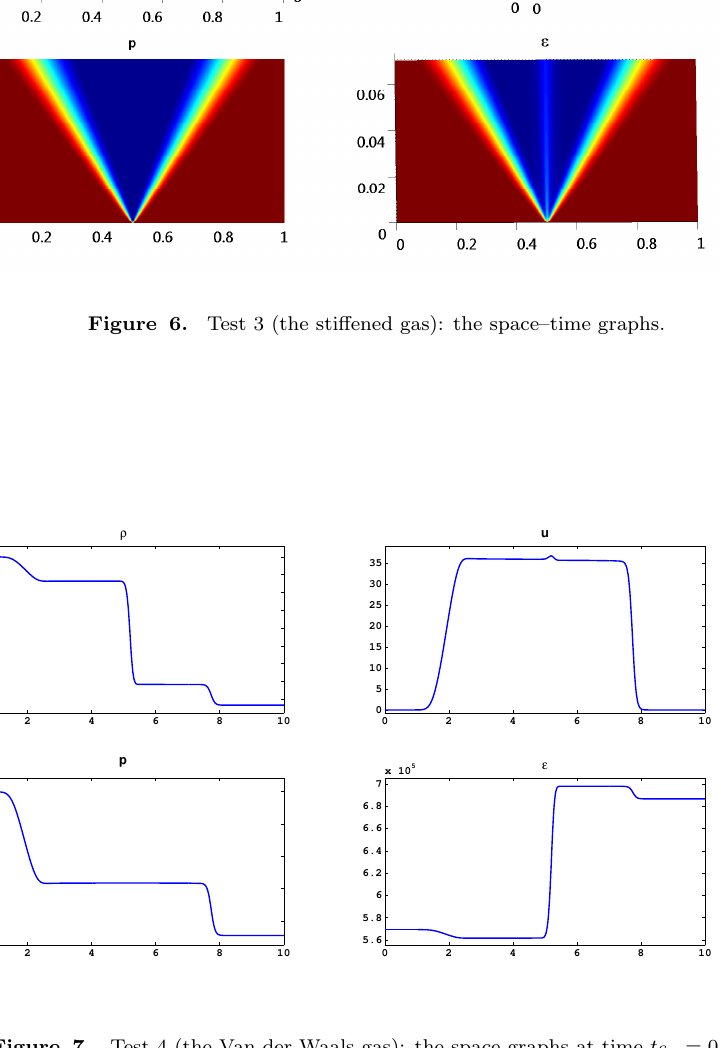
Figure 7. Test 4 (the Van der Waals gas): the space graphs at time t fin = 0 .